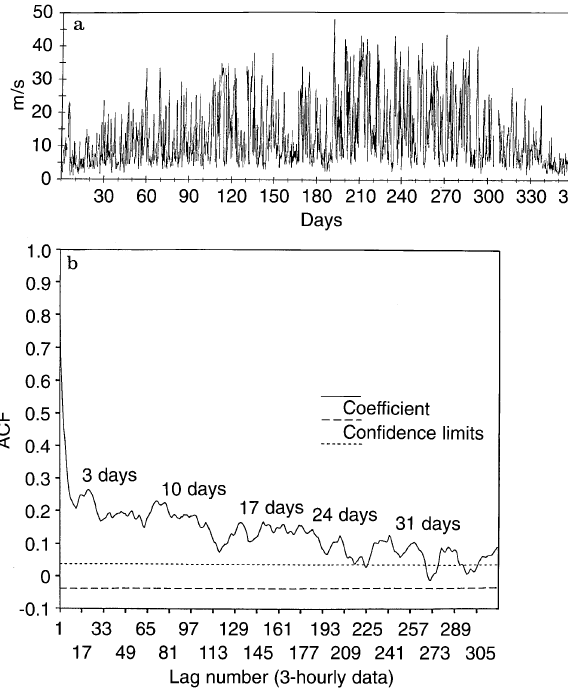
Fig. 7. a Maximum wind speed, AWS 7350, year 1989 (3-hourly data), b Maximum wind speed normalized autocor relation function, AWS 7350, year 1989 (3-hourly data)